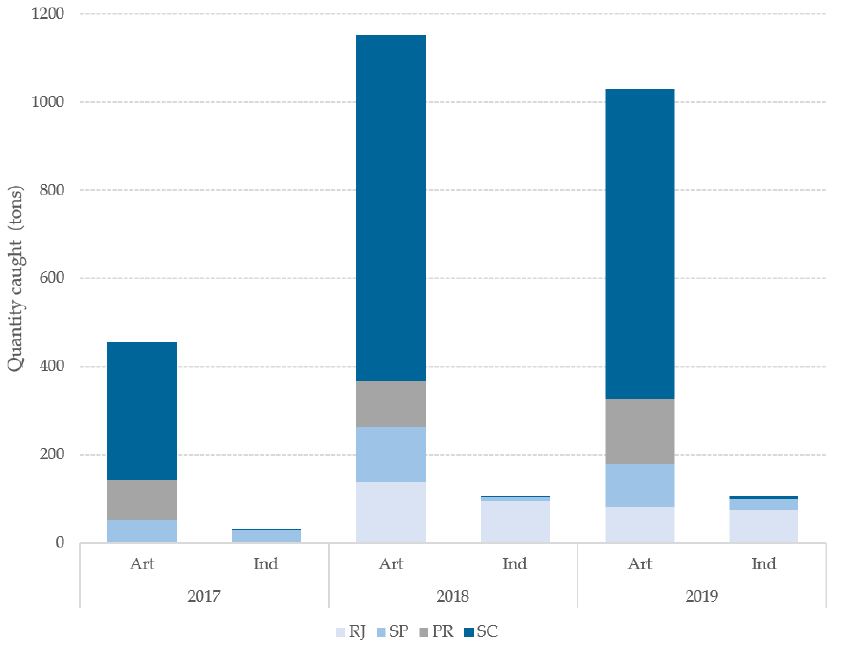
Figure 1. Quantity caught each year